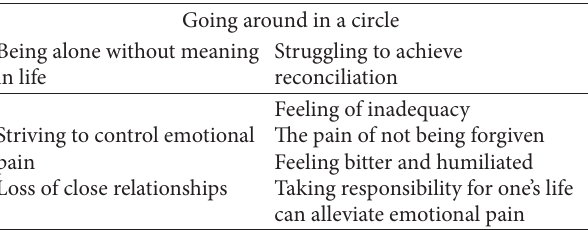
Table 1: Suicidal experiences in old